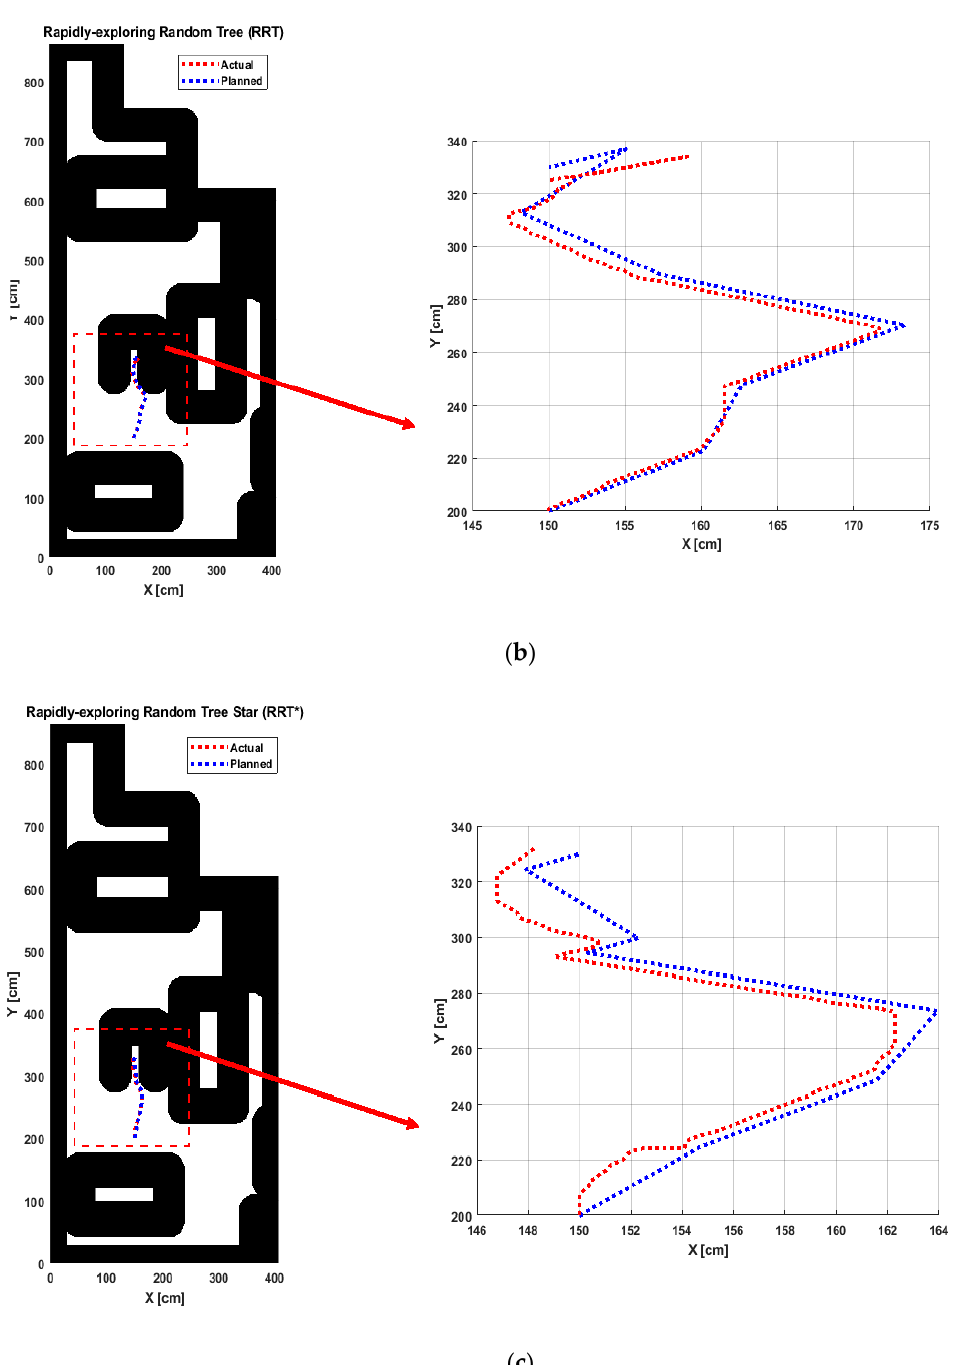
Figure 9. The experimental paths that are generated by using different path planning techniques in Map1. The blue line is the planned path, while the red line is the actual path. ( a ) The path planned by using the PRM technique. ( b ) The path planned by using the RRT technique. ( c ) The path planned by using the RRT* technique.